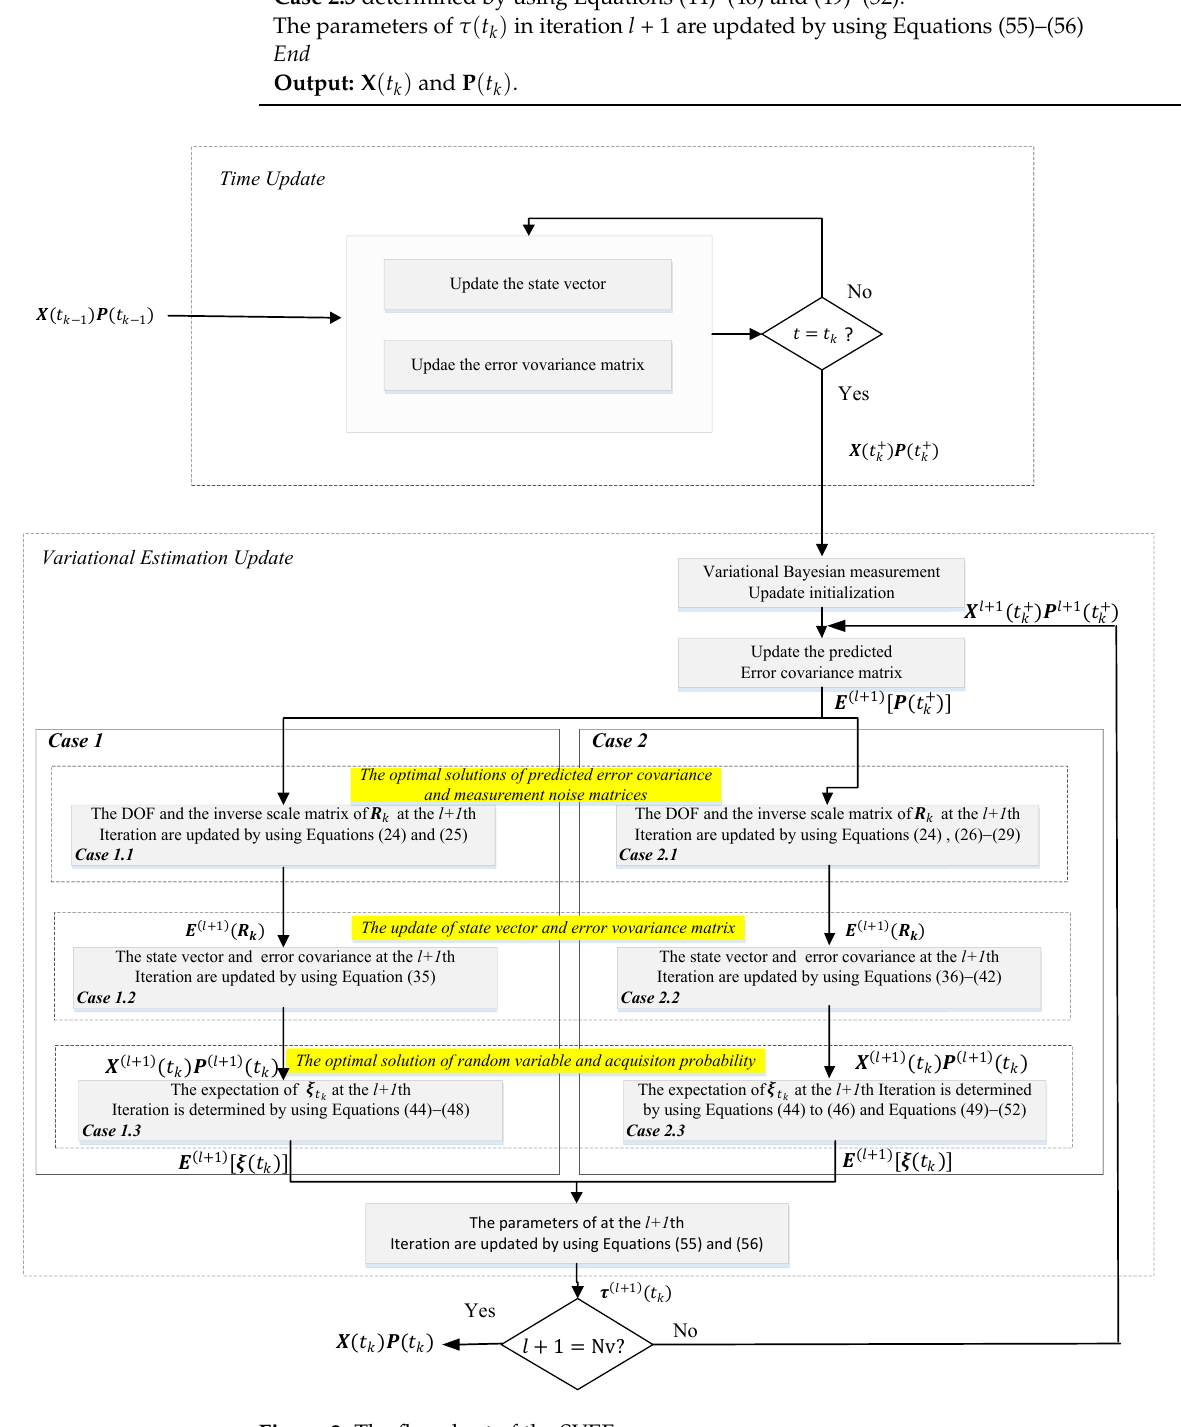
Figure 2. The flowchart of the SVEF.